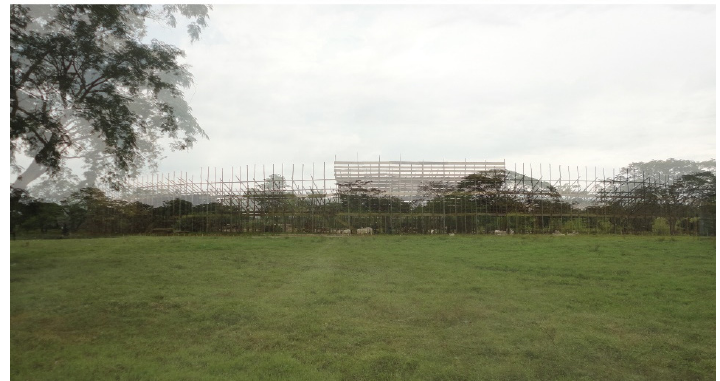
Figure 17. Sequence of images about the installation place of a Corraleja in the Municipality of Planeta Rica —Cordoba. In the Cordoba landscape the presence of cattle as well as nature is constant: before, while and after the ephemeral installation of the Corraleja . Source: Merwan Chaverra, 2017 [14]. The Corraleja represents a unique architectural example of its genre due to its provided